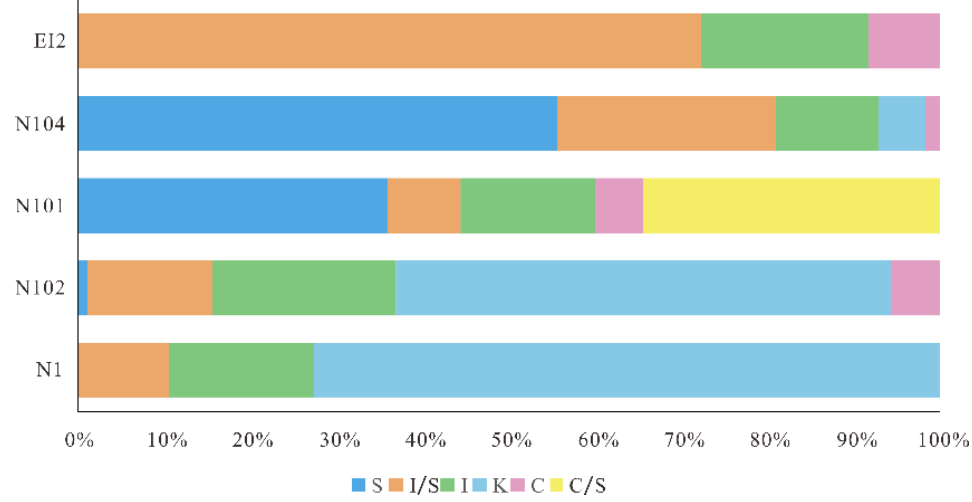
Figure 8. X-ray diffraction analysis of authigenic clay minerals in Lower Jurassic reservoir in Niudong, northern margin of Qaidam Basin.